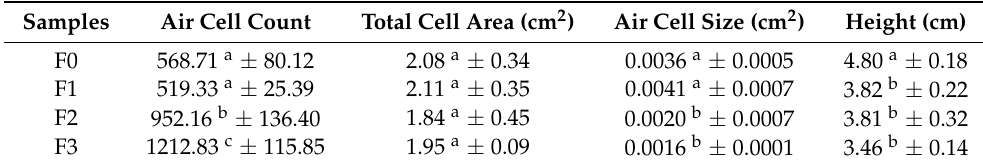
Table 3. Muffin height and crumb structure parameters.